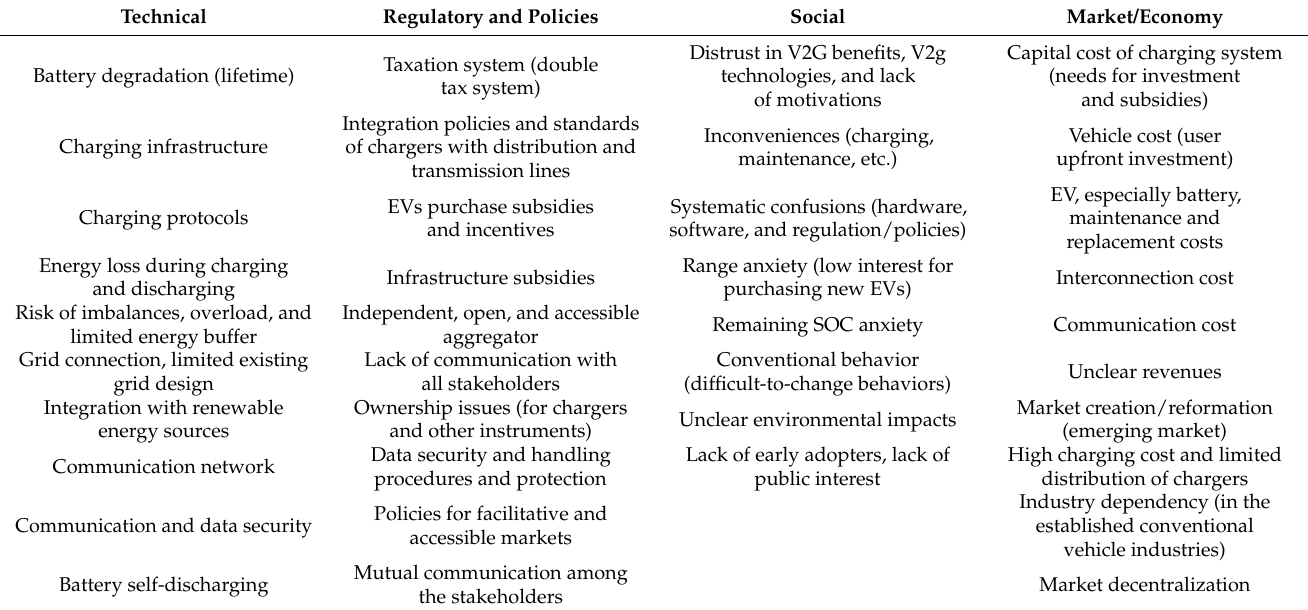
Table 5. Summarized potential challenges toward V2G implementation in different